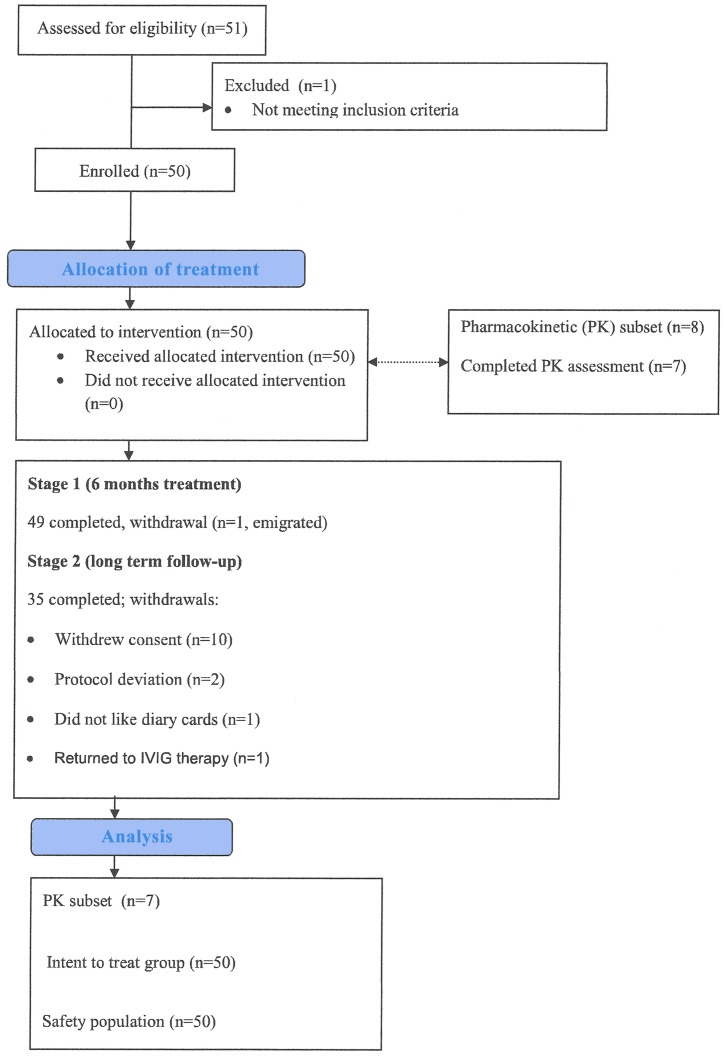
This is the flow diagram for patients enrolled in the SCIG01 clinical trial.